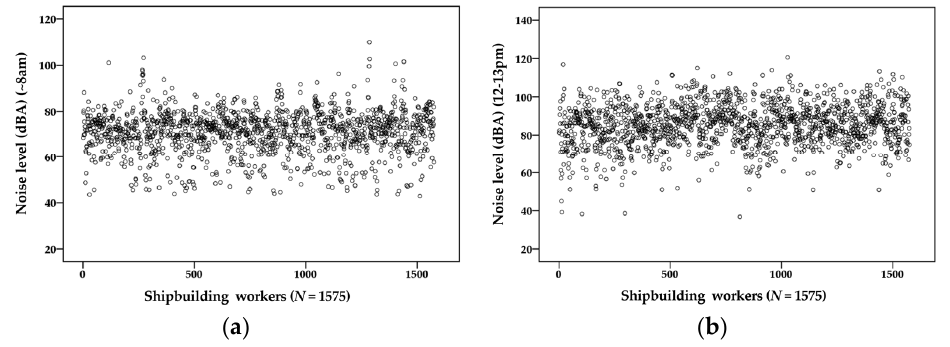
Figure 3. Patterns of noise exposure levels during the break time periods: ( a ) preparation of sam- pling instruments (~8am), ( b ) lunch break hour (12–13pm).